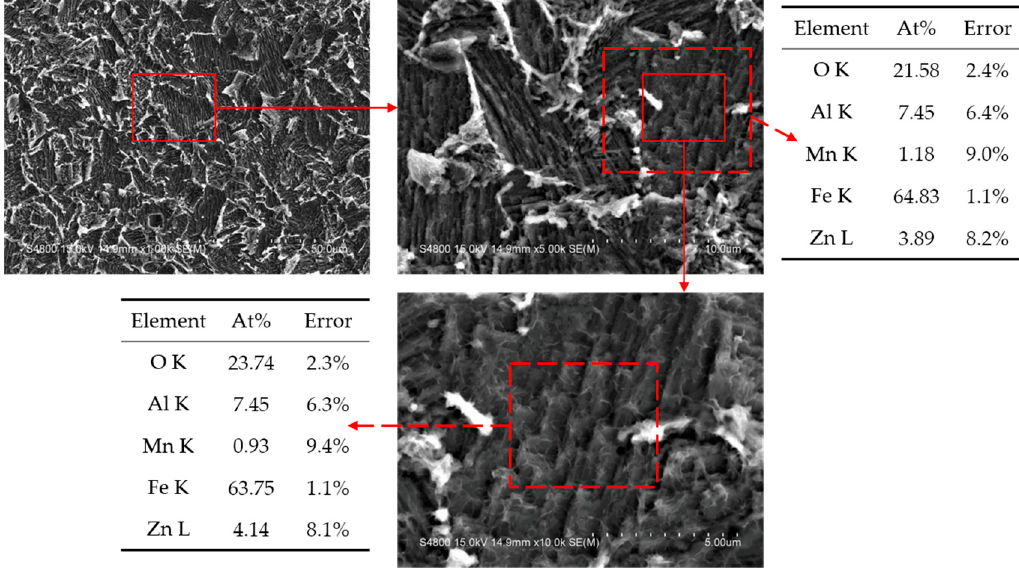
Figure 7. SEM images and the corresponding composition analysis of the passive film formed on A508-3 with the zinc–aluminum treatment.